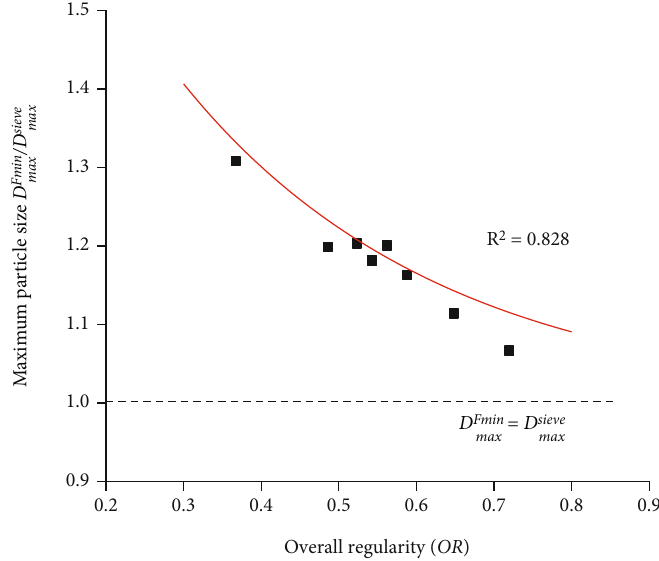
Figure 9: Curve fi tting for overall regularity (OR) versus D F min